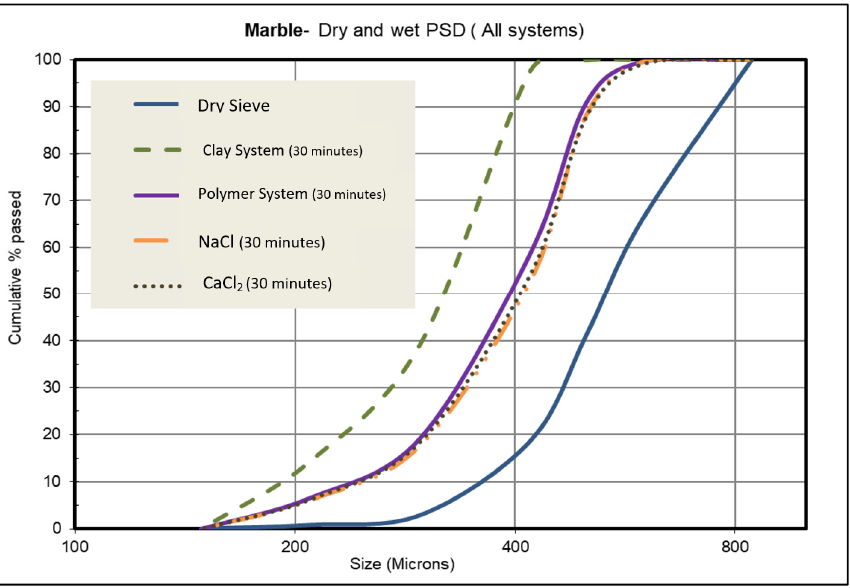
Figure 4. Dry and wet PSD of marble in the four carrier fluid systems with 30 min shearing intervals.